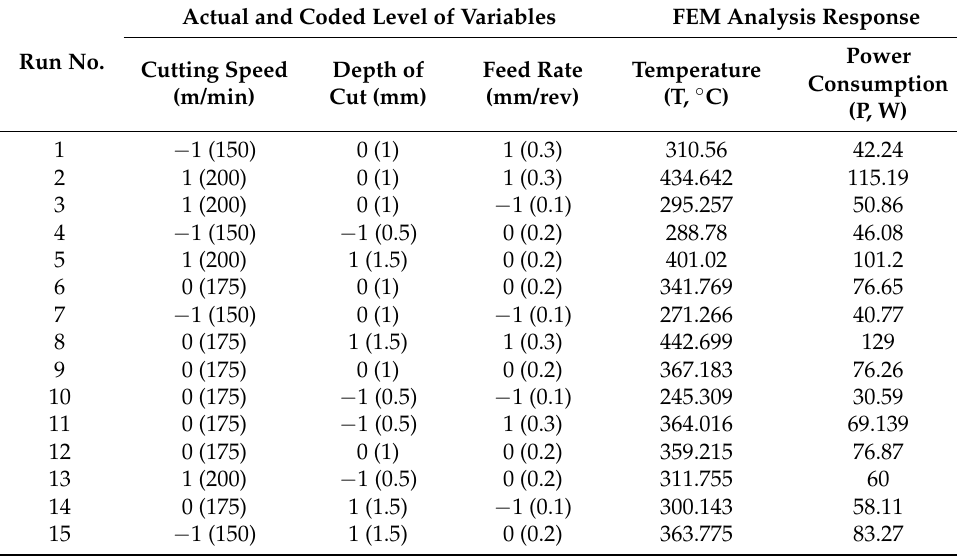
Table 8. The Box-Behnken design and FEM analysis